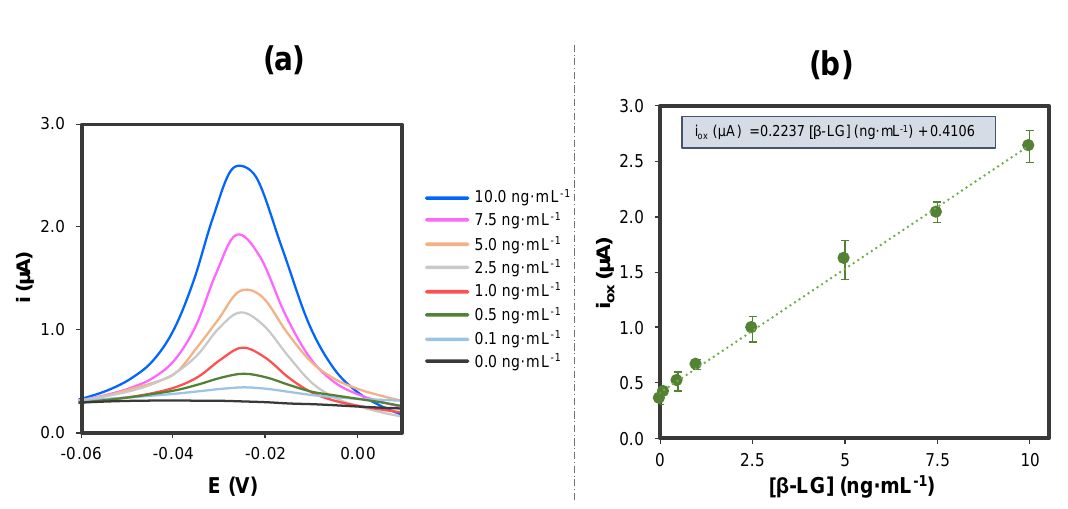
Figure 6. ( a ) DPV measurements for increasing concentrations of β -LG under the optimized conditions; ( b ) calibration curve for β -LG on AuNPs@PLL/GSPEs. Experimental conditions: [Apt-MB] = 1 µM, Incubation time: 45 min, oxidation DPV recorded between – 0.60 V and +0.15 V, using the following conditions: modulation time: 0.02 s; interval time: 0.5 s; step potential 0.005 V; modulation amplitude 0.10 V. Solutions made in 0.1 M PBS, 150 mM NaCl pH = 7.4. Data are given as average ± SD (n = 3).